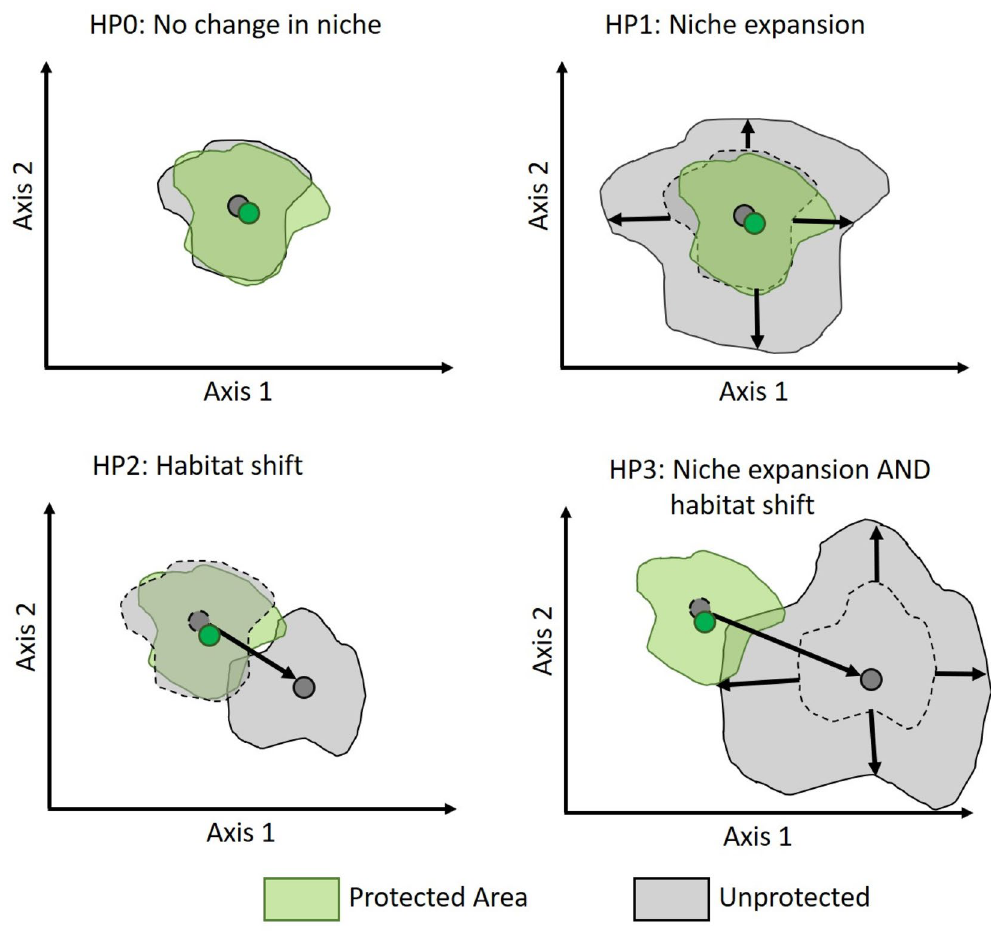
Figure 1. Schematic representation of our alternative hypotheses design. The null hypothesis (HP0) represents no change (difference) in the ecological niche between protected and unprotected areas within a certain species. Hypothesis 1 (HP1) represents a scenario of niche expansion outside protected areas (technically, this hypothesis also allows for niche contraction, although we do not expect it). Hypothesis 2 (HP2) represents a scenario where species shift their habitat between protected and unprotected areas. Hypothesis 3 (HP3) represents a scenario where species both expand (or contract) their niche volume outside protected areas and shift their habitat between protected and unprotected